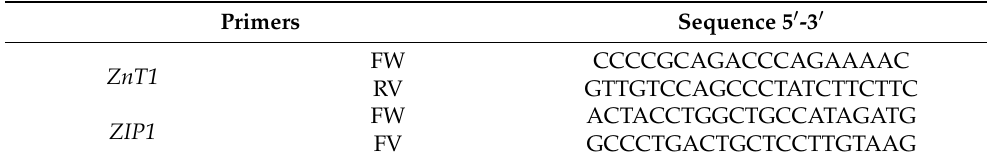
Table 1. Primers for the zinc channel transporters.